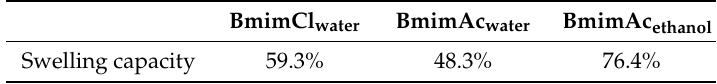
Figure 4. In vitro drug release curves for cellulose beads prepared from waste denim. Table 4. Swelling capacities of cellulose beads prepared from waste denim.